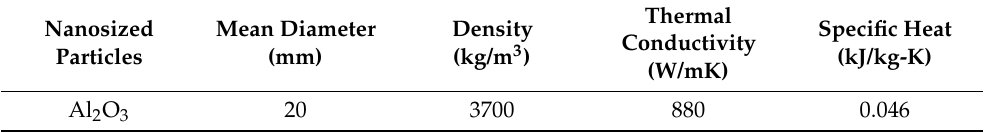
Table 1. Properties of the Al 2 O 3 particles.